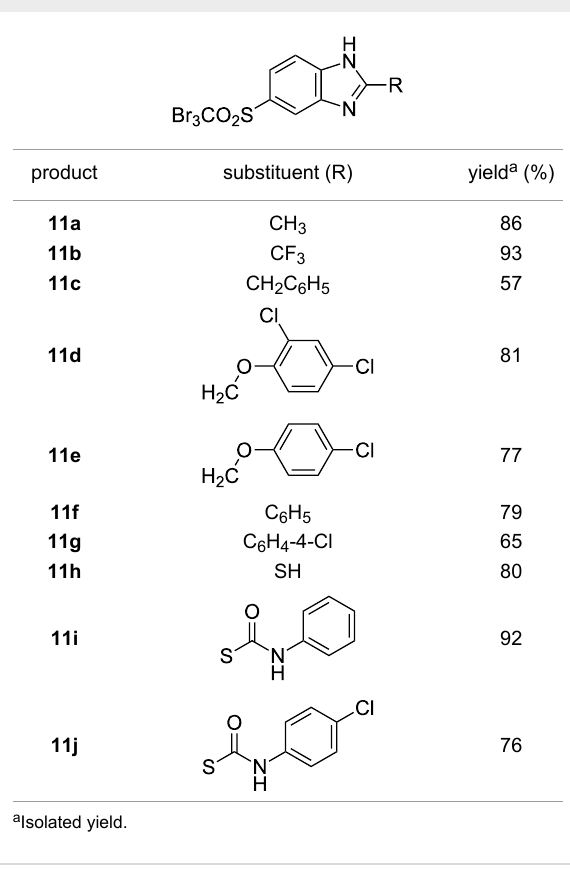
Table 3: 5-Tribromomethylsulfonylbenzimidazole